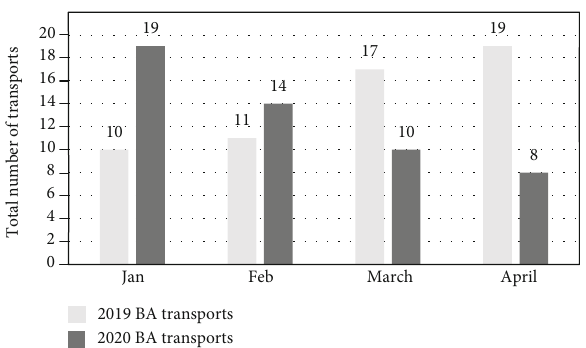
Figure 1: Total number of suspected stroke patients (aka brain attacks; BA) transported by